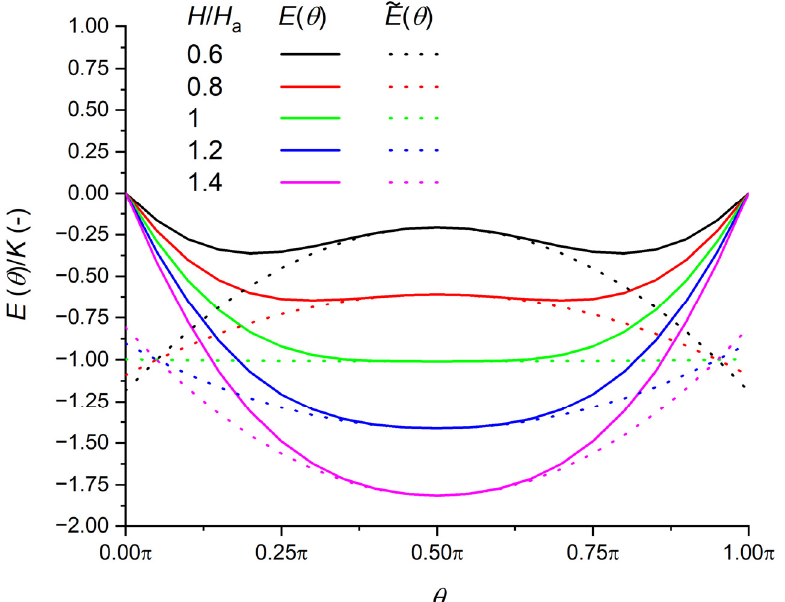
Figure A1. Angular dependence of the energy. Solid lines were constructed by using Equation (6) and dotted lines were based on the Taylor expansion, Equation (A3).